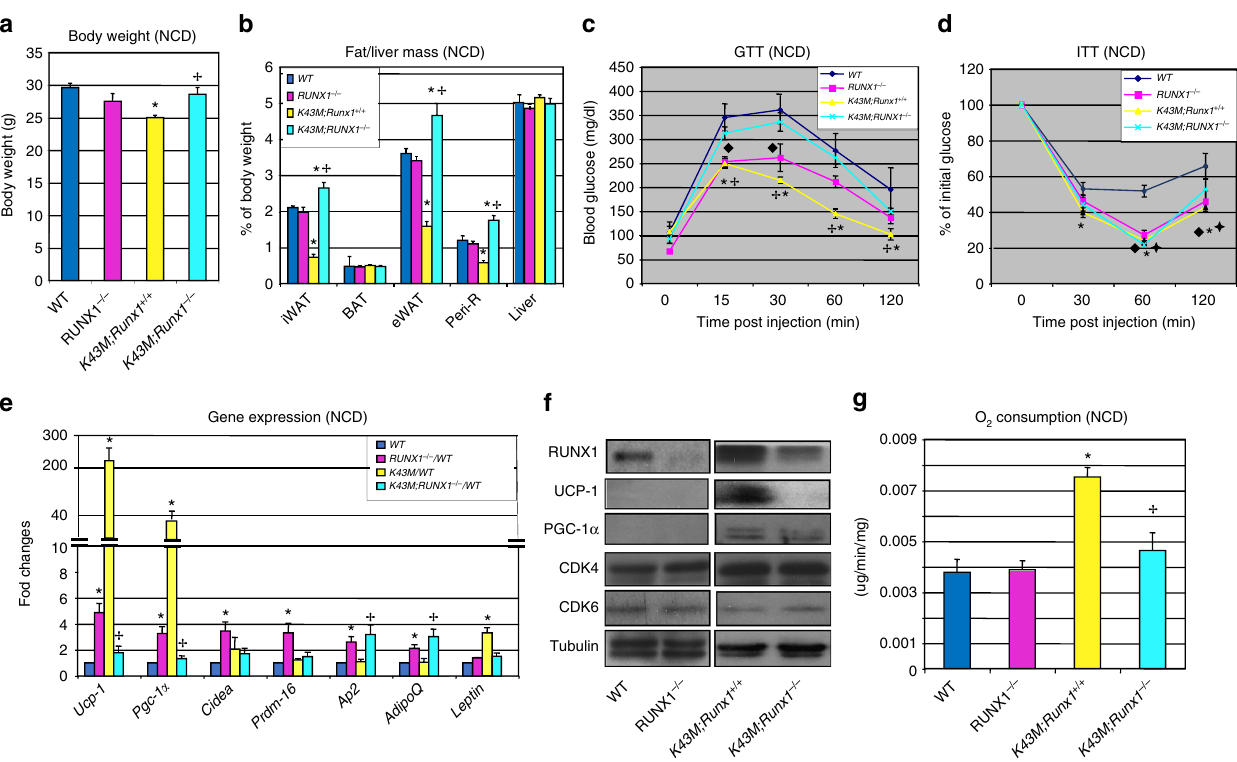
Fig. 7 CDK6 inhibits white fat browning by suppressing RUNX1. a Body weight of age-matched male mice (18-week-old) on NCD. * p < 0.05, ( n = 6), vs WT , t -test. ✢ p < 0.05, t -test, K43M;Runx1 − / − vs K43M . b Mass of various fat pads was normalized to body weight of male mice on NCD at 18 weeks of age. No signi fi cant changes were observed in the masses of BAT and livers among mice indicated under NCD. Data shown are mean ± S.E. ( n = 10 for each group), * p < 0.05, t -test, vs WT . ✢ p < 0.05, t -test, K43M;Runx1 − / − vs K43M . c GTT after 18 weeks on NCD. d ITT after 18 weeks on NCD. For c and d , n = 10 for each group, * p < 0.05, t -test, K43M vs WT , ♦ p < 0.05, t -test, Runx1 vs WT , ✢ p < 0.05, t -test, K43M;Runx1 − / − vs K43M , ◆ p < 0.05, t -test, K43M; Runx1 − / − vs WT . e Relative mRNA expression levels of BAT-speci fi c markers and WAT-speci fi c markers of iWAT tissues. Data shown are fold changes of mRNA normalized to the control WT , which is arbitrarily set to 1 unit. * p < 0.05 ( n = 6), vs WT control, t -test. ✢ p < 0.05, t -test, K43M;Runx1 − / − vs K43M . f Immunoblots of the indicated protein levels in iWAT from 50 μ g of cell lysates of the mice indicated at 18 weeks of age. α -Tubulin is used as an internal loading control. g Ex vivo oxygen consumption of iWAT homogenates from mice indicated. Data are expressed as mean ± S.E., * p < 0.05, vs K43M , t -test. ✢ p < 0.05, t -test, K43M;Runx1 − / − vs K43M . See also Supplementary Figs. 6 and